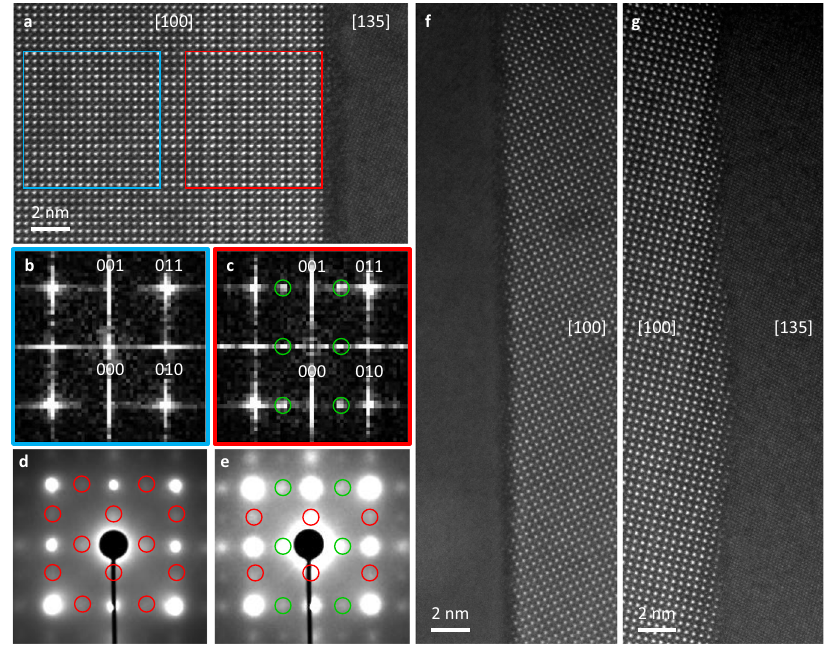
(cid:2) 1 Þ , LSTZ0.75 grain bulk along the [100] zone axis. The ð 0± 1 1 Þ , ð 0± 1 0 Þ , ð 0± 1 2 2 2 Þ , ð 00± 1 Þ , and ð 01± 1 Þ diffraction spots failed to be observed in the cor- ð 0 (cid:2) 1± 1 2 2 2 respondingFFTpatternwerecircledinred. e SAEDpatternofsuperlatticestructure Þ , ð 00± 1 Þ , and near (010) faceted GB along the [100] zone axis. The ð 0 (cid:2) 1± 1 2 2 Þ diffraction spots failed to be observed in the corresponding FFT pattern ð 01± 1 2 werecircledinred. f , g Atomic-resolutionHAADF-STEMimagesofgeneralGBs.The left-side grain in ( f ) was not oriented along any particular zone